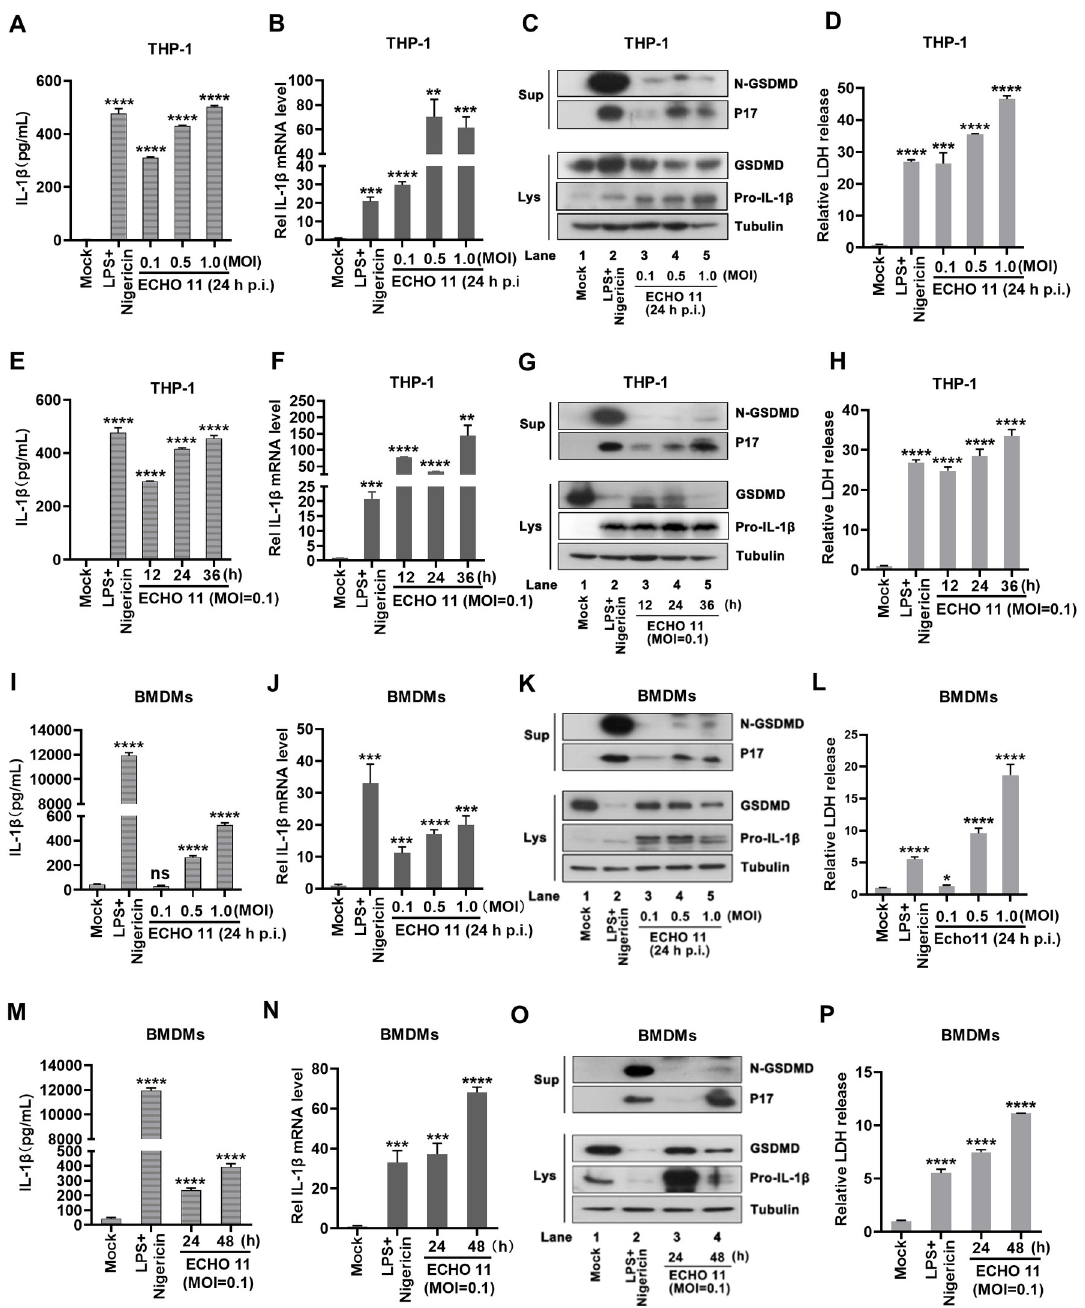
Fig 2. ECHO 11 infection induces pyroptosis in cells and ex vivo . THP-1 cells ( A-D ) or BMDMs ( I-L ) were infected with ECHO 11 at an MOI of 0.1, 0.5 or 1 for 24 h or THP-1 cells ( E-H ) or BMDMs ( M-P ) were infected with ECHO 11 at an MOI of 0.1 for 12, 24 or 36 h. Cells treated with LPS (10 μ g/ml) for 5 h and 10 μ M Nigericin for 1 h was used as the positive control, while cells without treatment (Mock) were used as the negative control. ( A , E , I and M ) Mature IL-1 β levels in the supernatants were determined by ELISA. ( B , F , J and N ) The intracellular mRNA levels of IL-1 β were measured by qRT-PCR, and the level of IL-1 β mRNA in mock cells were defined as 1-fold. ( C , G , K and O ) GSDMD-N and P17 in the supernatants (Sup), and GSDMD and pro-IL-1 β in cell lysates (Lys) were examined by Western blotting with the indicated antibodies. ( D , H , L and P ) The LDH release in the supernatants were determined by cytotoxicity assay, and the level of LDH in mock cells was defined as 1-fold. Data represent means and SD from three repeated experiments. � , P < 0.05; �� , P < 0.01; ��� , P < 0.001; ���� , P < 0.0001, as measured by one-way ANOVA.